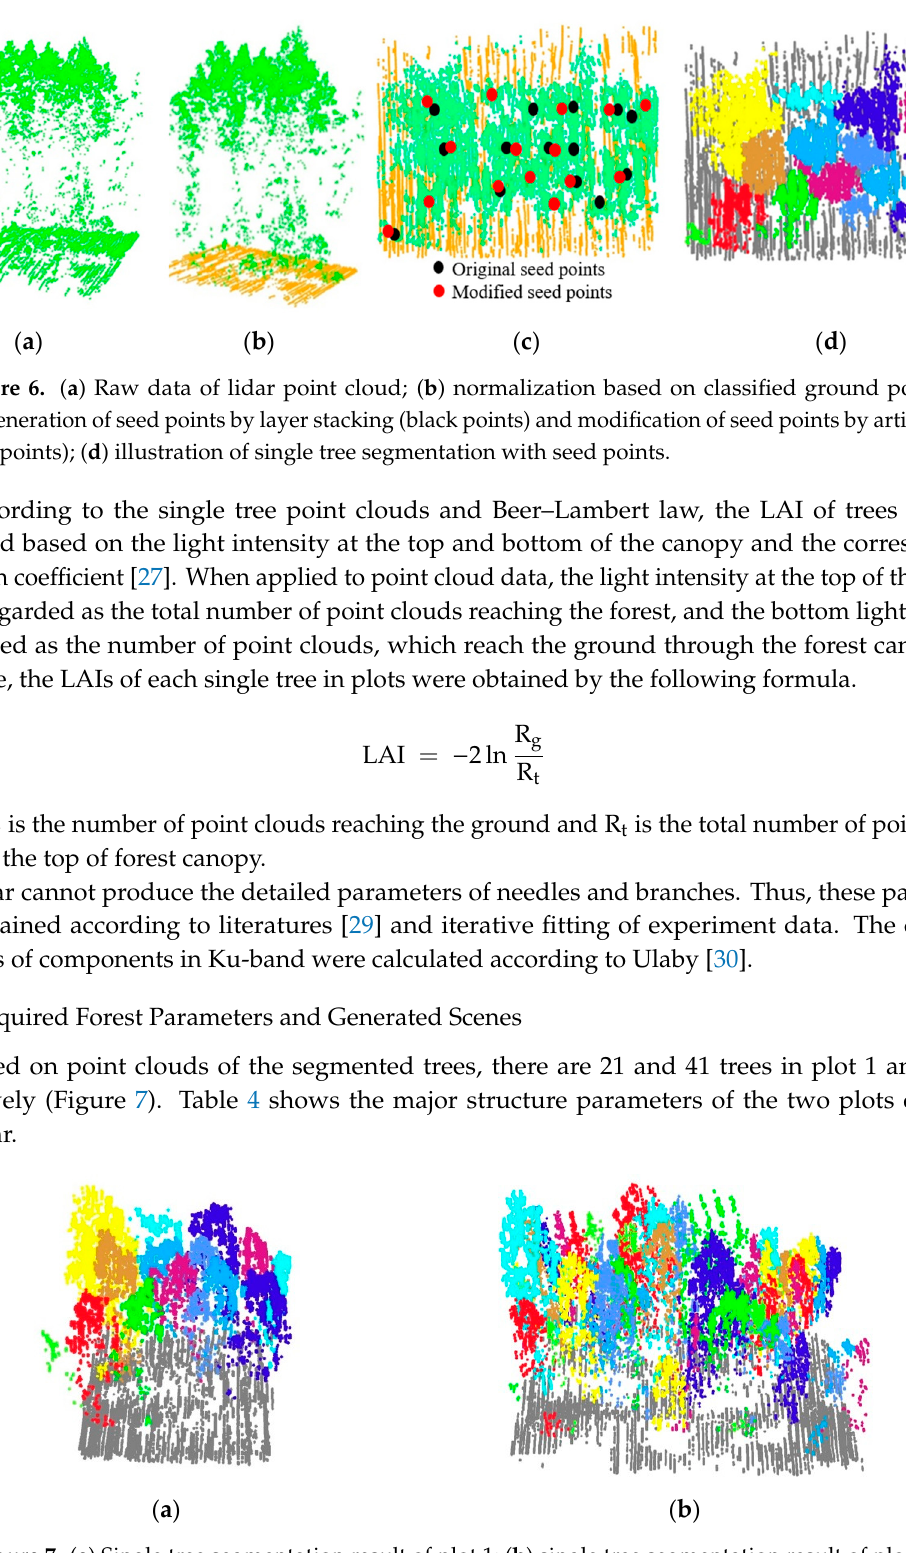
Figure 7. ( a ) Single tree segmentation result of plot 1; ( b ) single tree segmentation result of plot 2. Table 4. The major structure parameters of the two plots extracted from lidar.